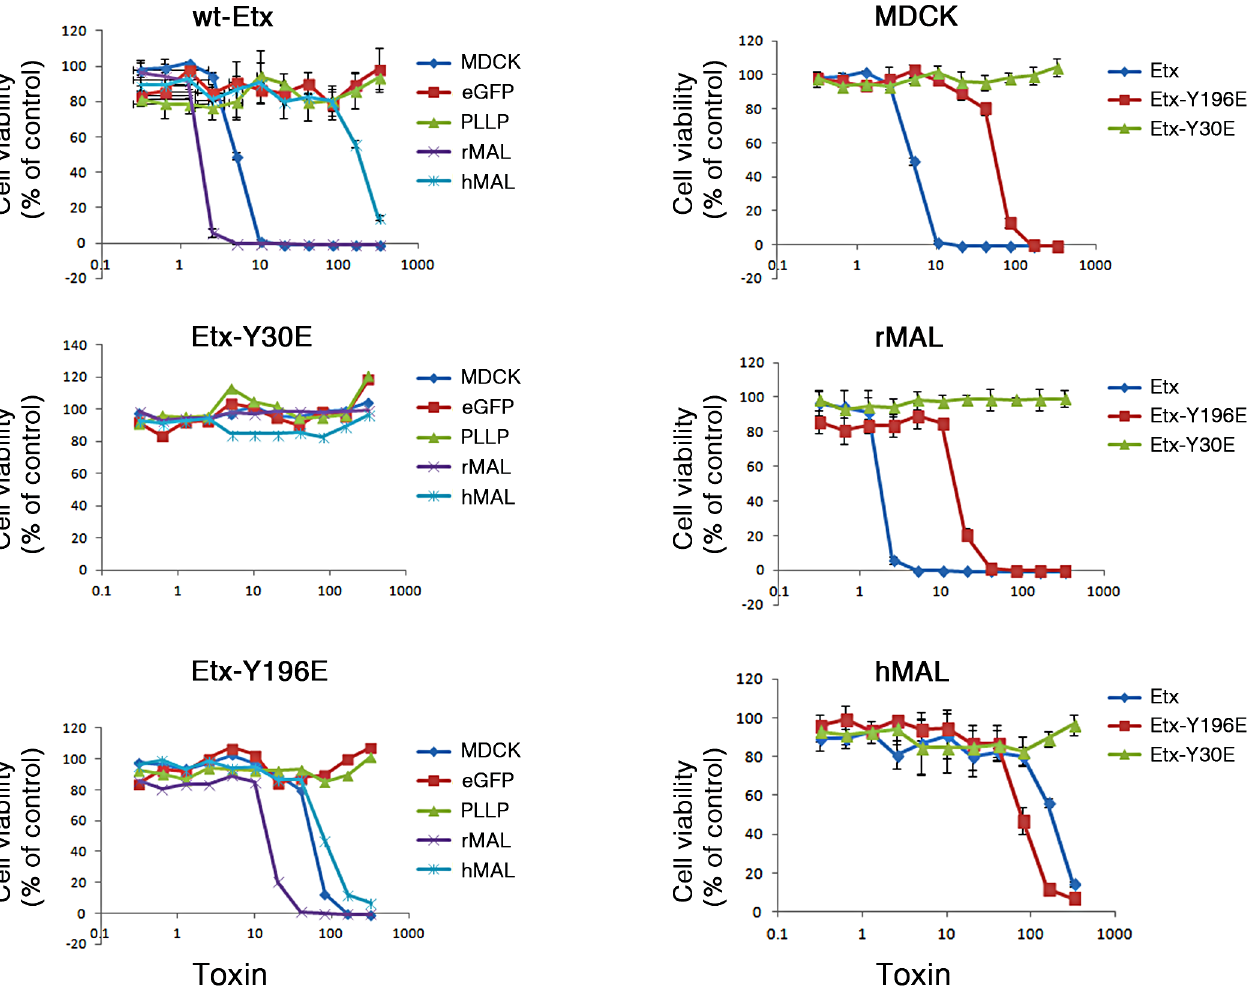
Fig 8. Specific aromatic residues within domain 1 of ETX are required for toxin activity in MAL-expressing CHO cells. The plots on the left show the cytotoxicity results on MDCK cells, CHO cells expressing rMAL or hMAL, and the two control CHO lines (GFP and the tetraspan PLLP). Cells expressing rMAL and MDCK cells show similar sensitivity to ETX whereas the cells expressing hMAL are less sensitive. The Y30E mutant eliminates ETX toxicity in all cell lines, while the Y196E mutant significantly attenuates the toxin activity in MDCK cells and rMAL cells. The plots on the right compare the same data by cell line rather than by toxin. On both MDCK and on cells expressing rMAL, about 10-fold greater amounts of Y196E versus wt-ETX are required to kill cells. In contrast, with cells expressing hMAL, there is little difference between the wt-ETX and the Etx-Y196E mutant. Data are means and SD from a single experiment and are representative of three independent triplicate experiments.